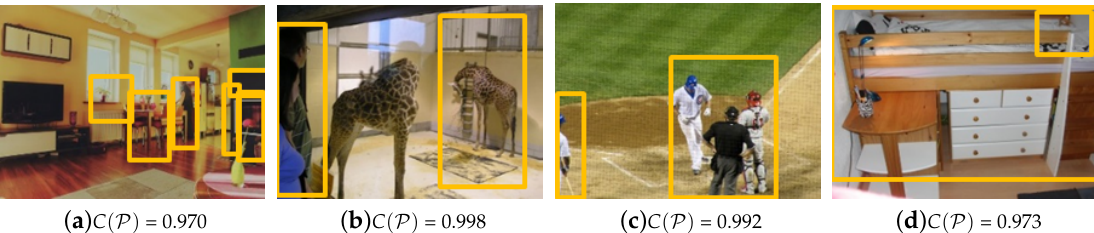
Figure 11. CL-CNN results with natural image input. The average output value was 0.98 or higher. The yellow box shows the normal detection results by R-CNN, and red box represent the detection result by our method. ( a ) indoor scene, ( b ) giraffes in the glass cage, ( c ) baseball scene, ( d ) indoor scene with shelf bed.